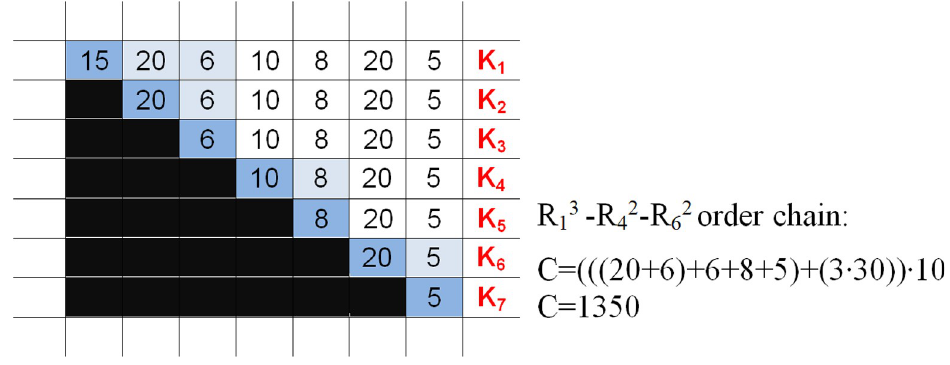
Fig 3. Another alternative: Drawing the EPP house for the optimal distribution.